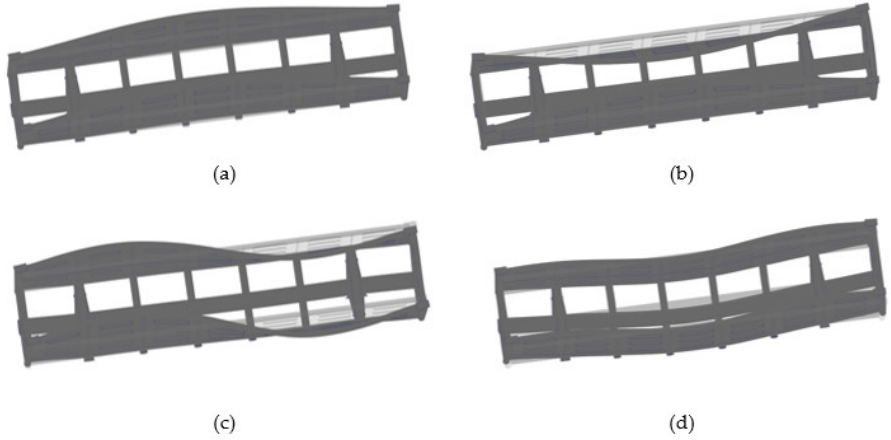
Figure 6. Forms of the oscillations of the bearing structure of an open wagon (scale 20:1) ( a ) 1st natural frequency; ( b ) 2nd natural frequency; ( c ) 3rd natural frequency; ( d ) 4th natural frequency. The natural oscillations obtained are given in Table 1. Table 1. Natural oscillation frequencies in the bearing structure of an open wagon. Frequency, Hz Frequency, Hz Form Of Oscillations (Filler-Free Construction) (Filled Construction)